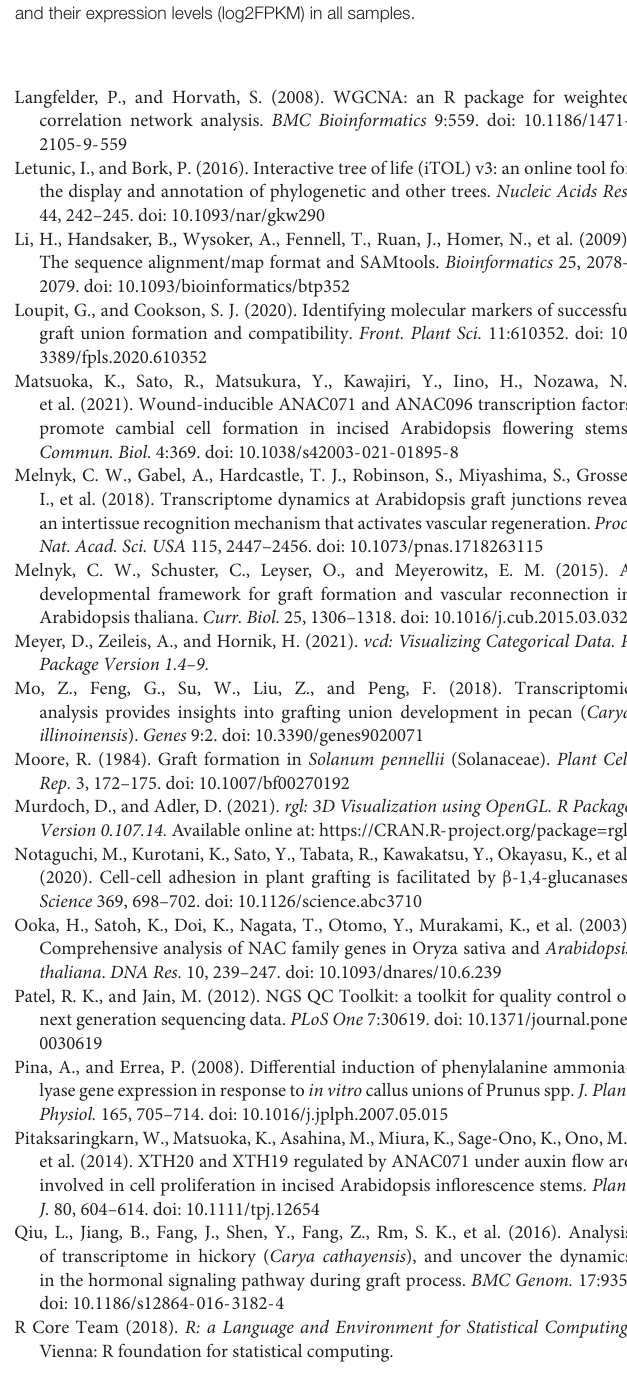
Supplementary Figure 3 | ML tree and expression patterns of all NAC homologs in Arabidopsis and tomato. Supplementary Figure 4 | Log2FPKM values of genes in different species and different sample types. The significances of Kappa consistency tests between two species within each clade were marked with * ( p <